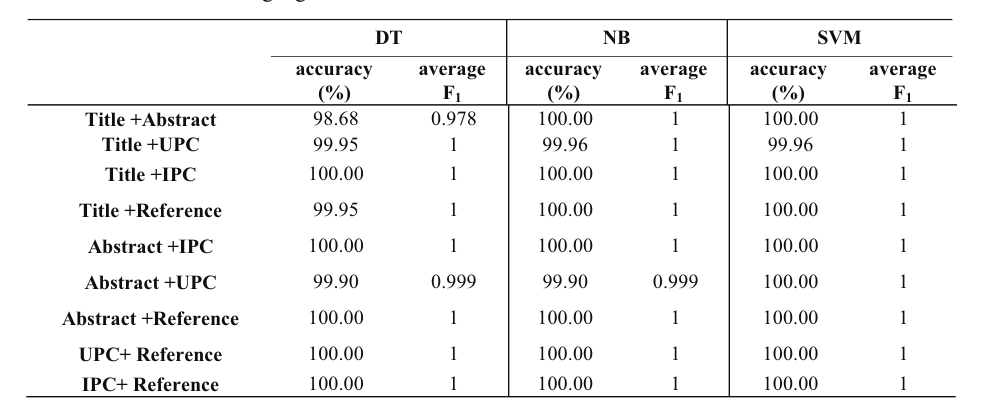
Table 4. Classification performances based on single sections of a patent document using three different machine learning